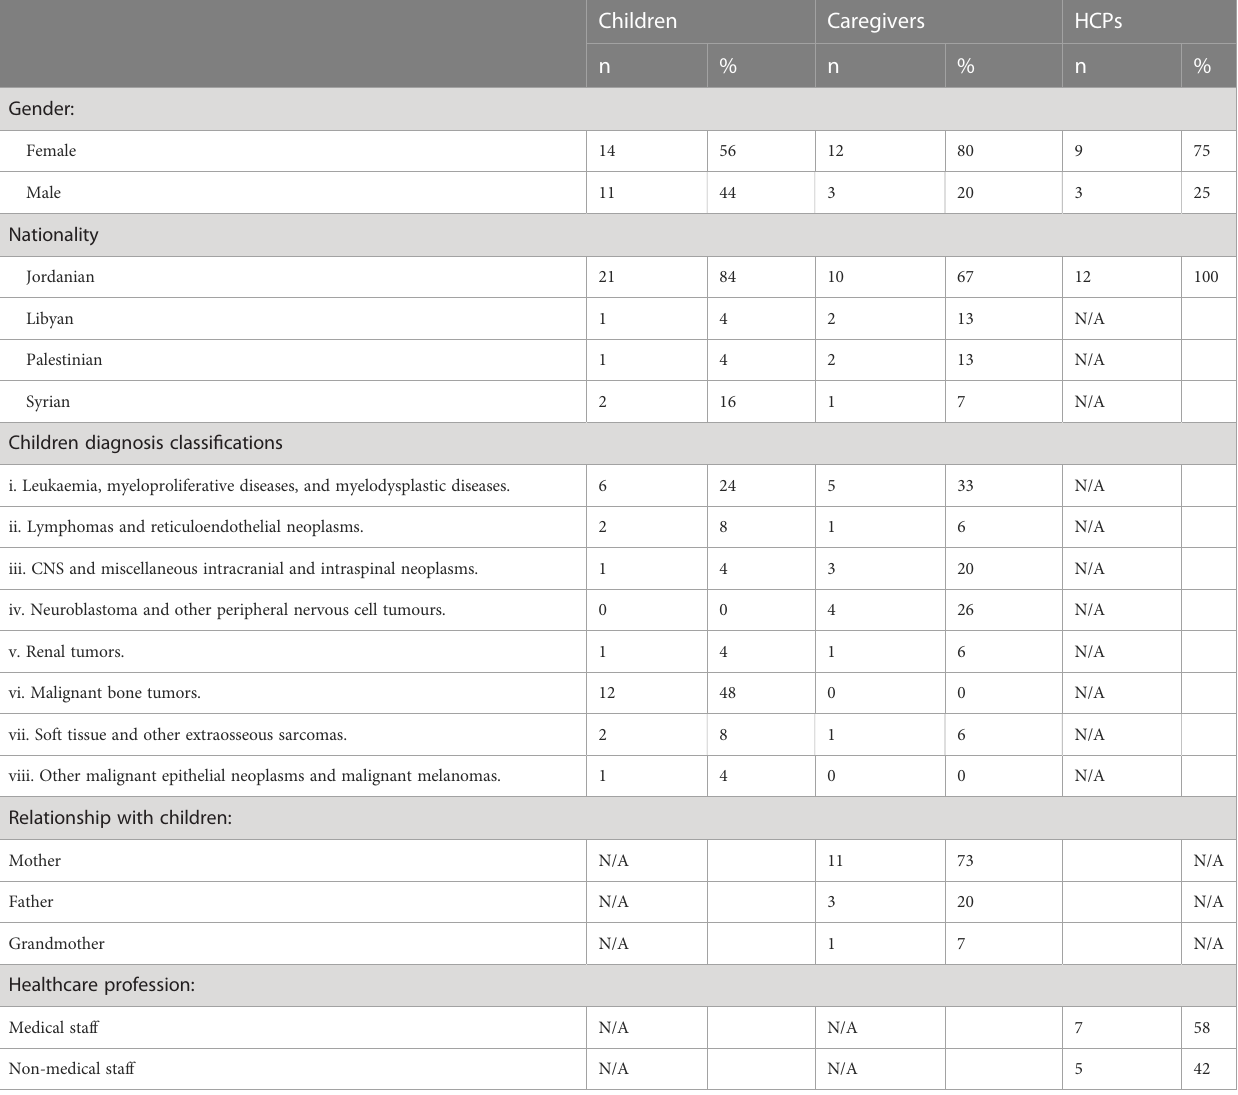
TABLE 2 Participant characteristics